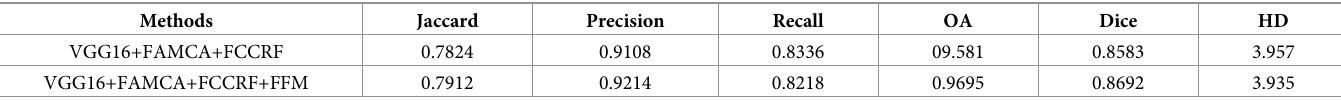
Table 3. Ablation study for FFM module.